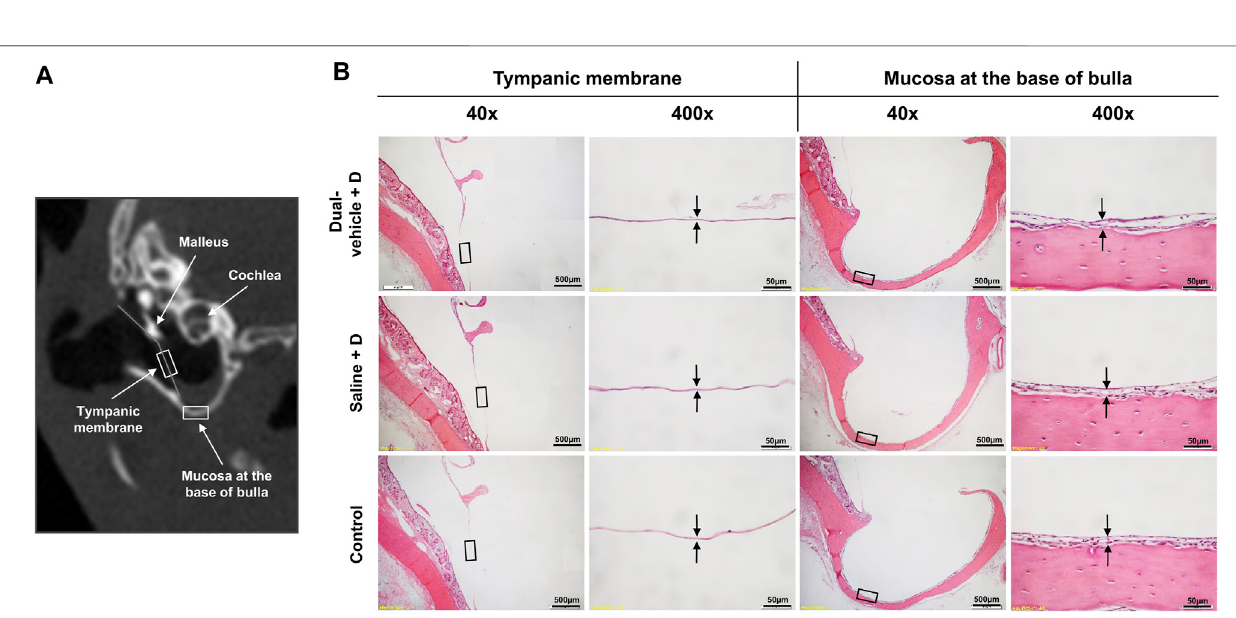
Frontiers in Pharmacology |